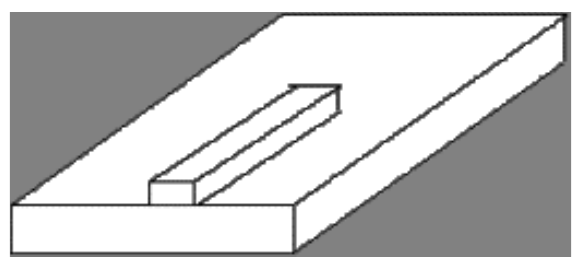
curve).FIG. 1. Crystal with a micron-sized strip on the surface.